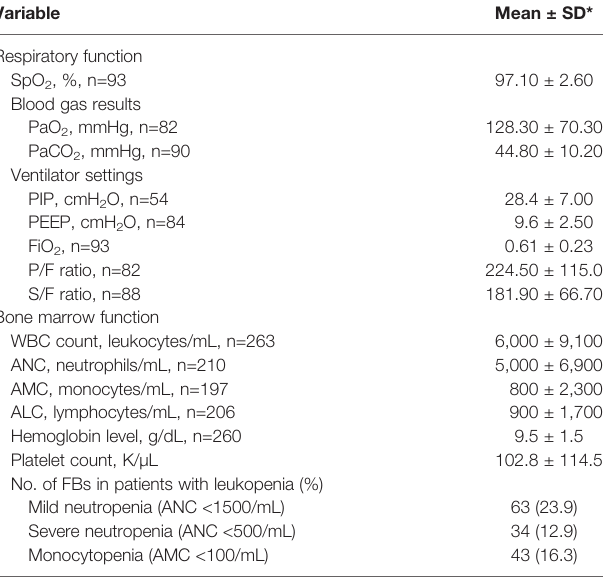
TABLE 4 | Clinical data.